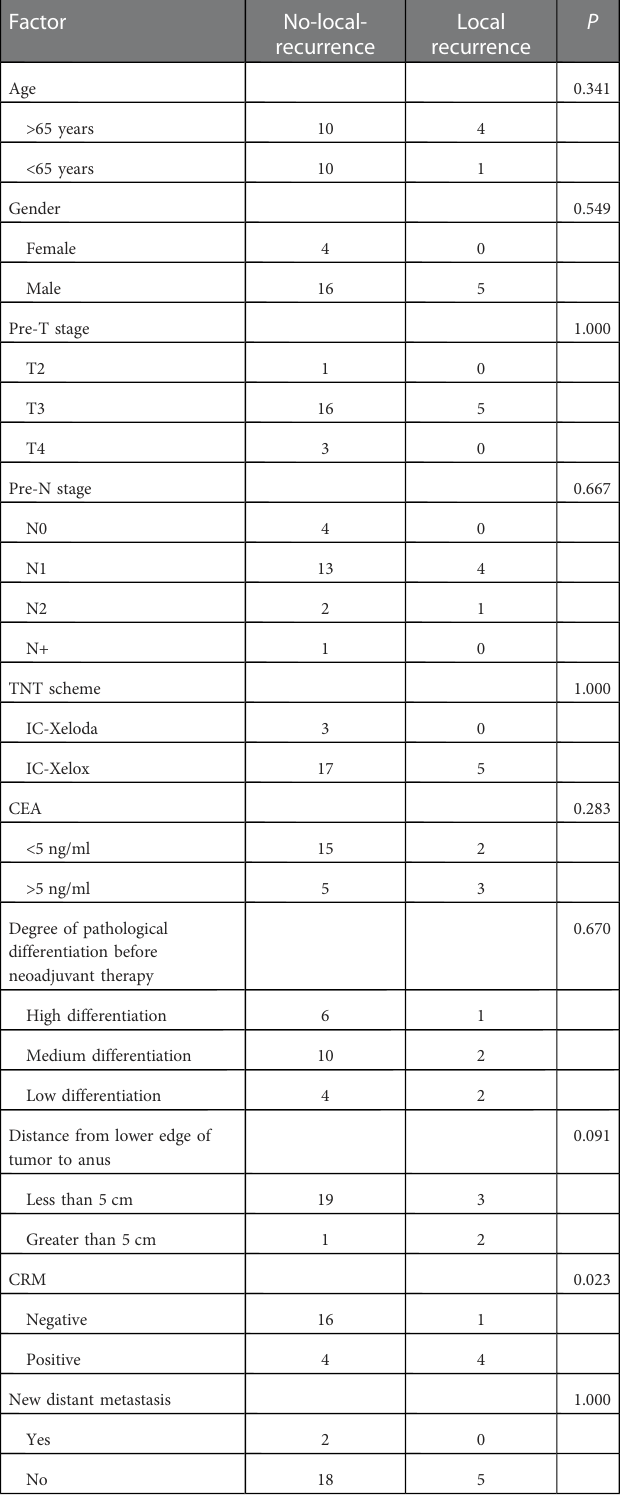
TABLE 3 Single-factor analysis of clinical factors affecting prognosis of local recurrence during W&W. CRM had a signi fi cant effect on local recurrence in cCR patients during